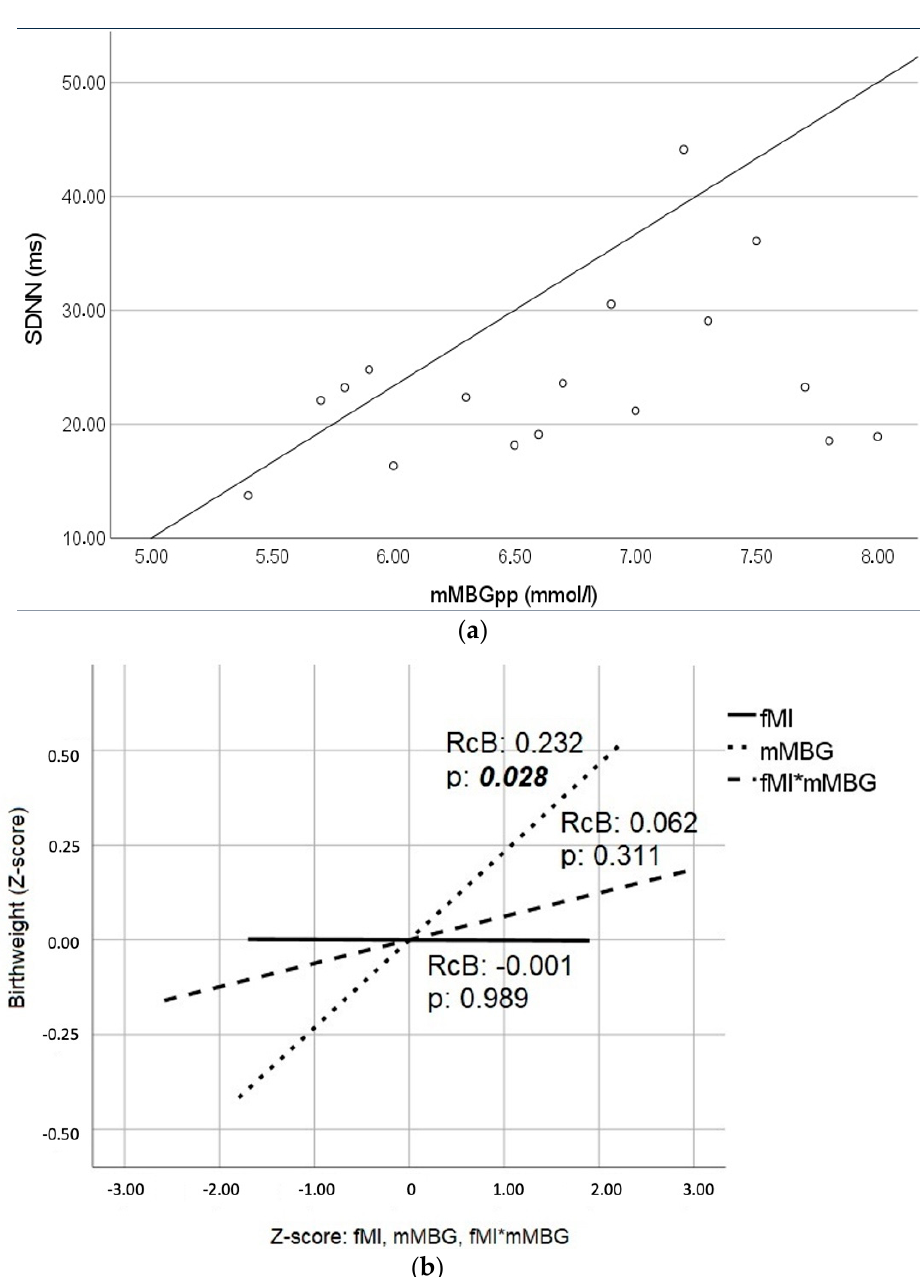
Figure 3. ( a ) Regression analysis between mean one-hour postprandial maternal blood-glucose (mMBGpp) levels of the seven days prior to the respective fMCG recording and SDNN as a marker of overall fetal HRV representing mainly sympathetic activity (RcB 0.339; p = 0.009). ( b ) Z-score normalized values for birthweight, fetal movement index (fMI), mean maternal blood-glucose (mMBG) of the seven days prior to the respective fMCG recording and the interaction term fMI*mMBG (general estimating equation model). Birthweight was positively related to mMBG (RcB 0.232; p = 0.028) but not fMI alone (RcB − 0.001; p = 0.989). The interaction fMI*mMBG attenuated the effect between mMBG and birthweight (RcB 0.062; p = 0.311).